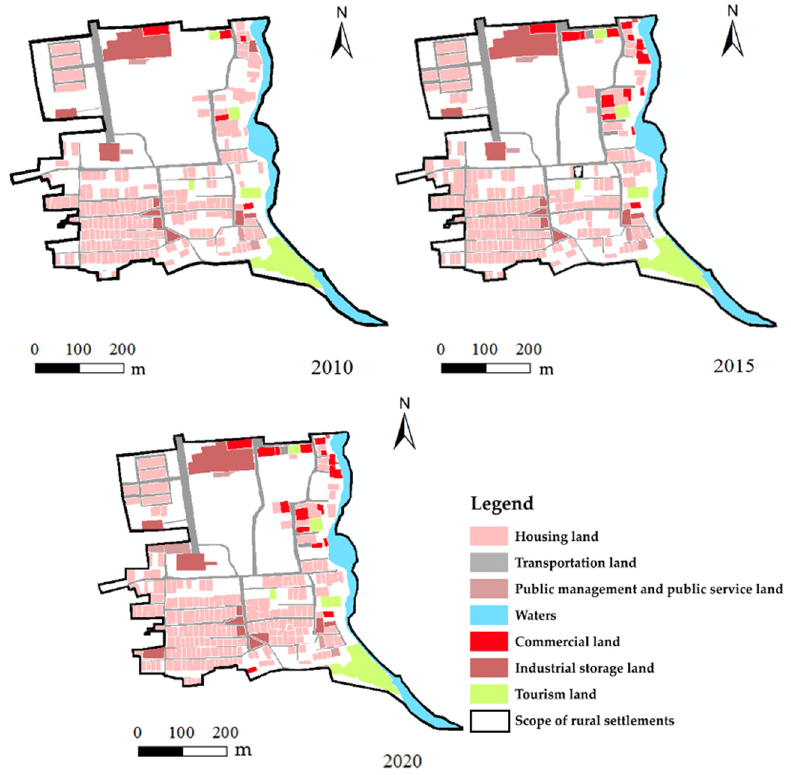
Figure 4. The evolution of rural residential land in Shuiyukou Village from 2010 to 2020.